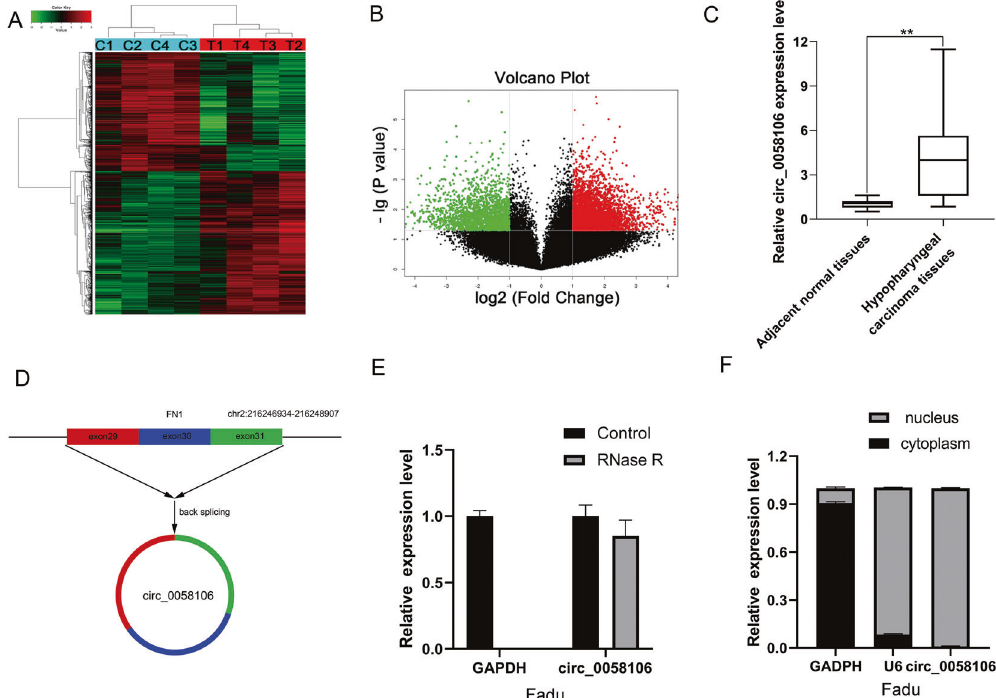
Fig. 1 circ_0058106 was upregulated in HSCC tissues by using RNA pro fi ling of circRNAs and qRT-PCR. A Heat map and hierarchical clustering analysis revealed different circRNA expression pro fi les between HSCC tissues (C1, C2, C3, and C4) and adjacent normal tissues (T1, T2, T3, and T4). B The volcano map showed that the circRNAs in HSCC tissues were dysregulated (red or green dots represent the upregulation or down-regulation of circRNA) in HSCC tissues. (FC ≥ 2.0, P value < 0.05) C circ_0058106 expression levels were signi fi cantly upregulated in tumor tissues than in corresponding normal tissues by using qRT-PCR. ( n = 20, * P < 0.05; ** P < 0.01) D The schematic diagram showed the head-to-tail splice site of the circ_0058106 PCR product ampli fi ed by divergent primers, and the splice site had been veri fi ed by Sanger sequencing. E Total RNA with or without RNase R (3U/mg) were treated for reverse transcription, circ_0058106 and GAPDH mRNA expression levels were detected by qRT-PCR. F qRT-PCR analysis indicated the distribution of GAPDH, U6 and circ_0058106 in the nucleus and cytoplasm of Fadu cells ( n =